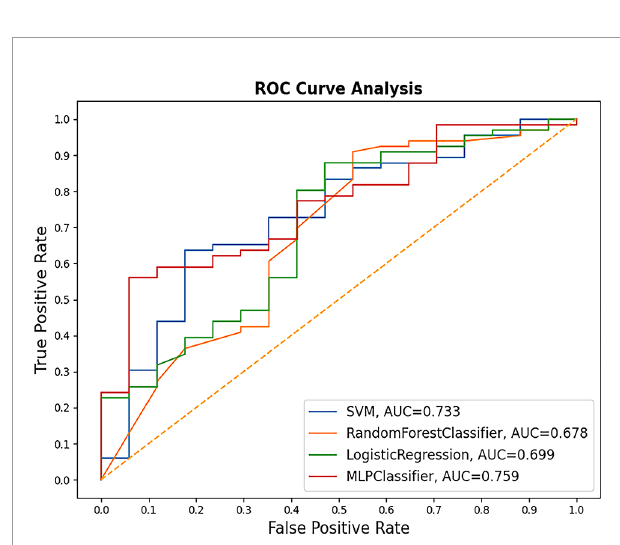
FIGURE 2 | Performances of models with optimal number of structured features. MLP performed the